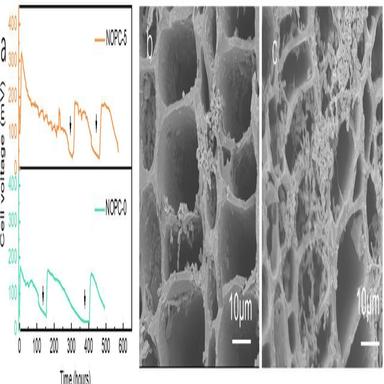
(a) Cell voltage output over three periods of NOPC-0-MFC and NOPC-5-MFC; SEM images of the colonized anode of (b) NOPC-0 and (c) NOPC-5.